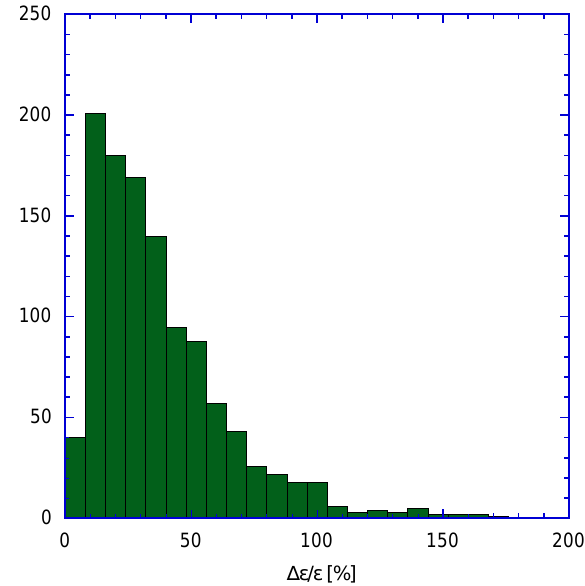
FIG. 9. (Color) Histogram of 1100 simulations of accelerator structure misalignments in the NLC linac; the average dilution is 35%, but the distribution of errors is roughly exponential and thus has large